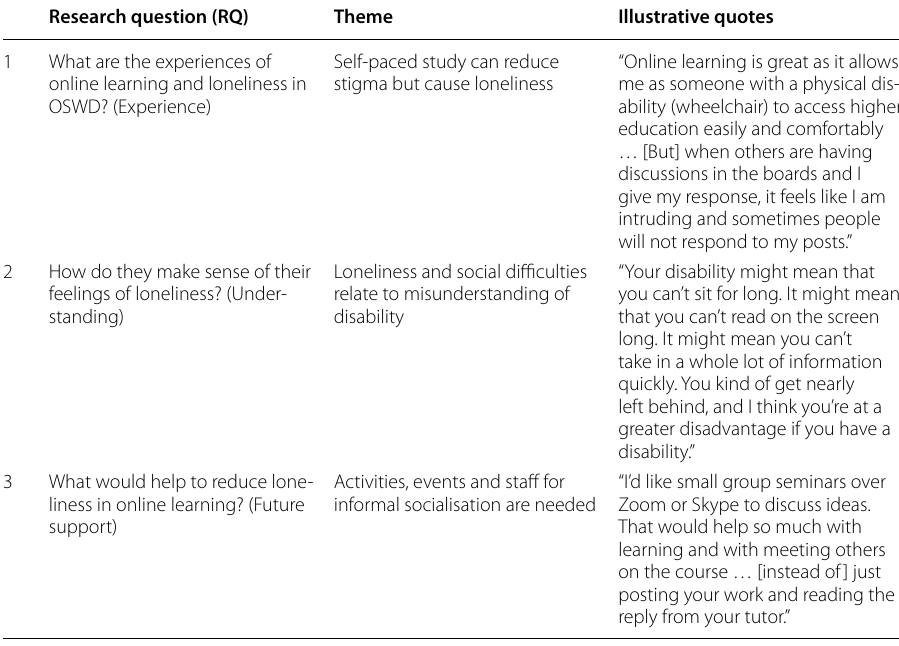
Table 2 Research questions, themes and examples of participant excerpts Research question